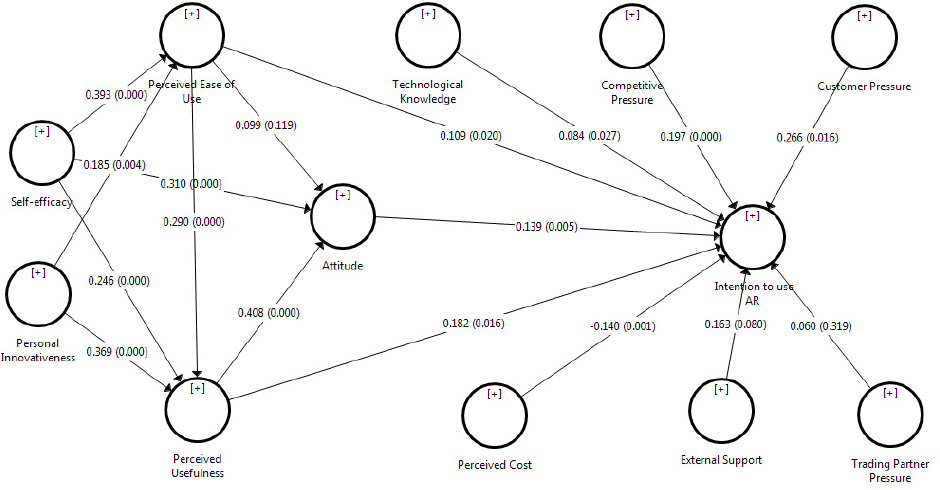
Figure 3. Structural model.